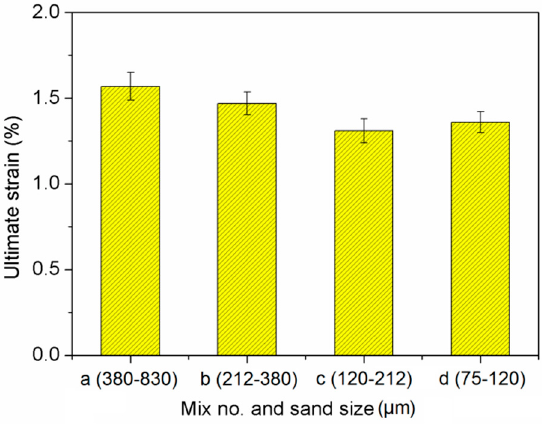
Figure 9. Ultimate strain of cement-based composites.